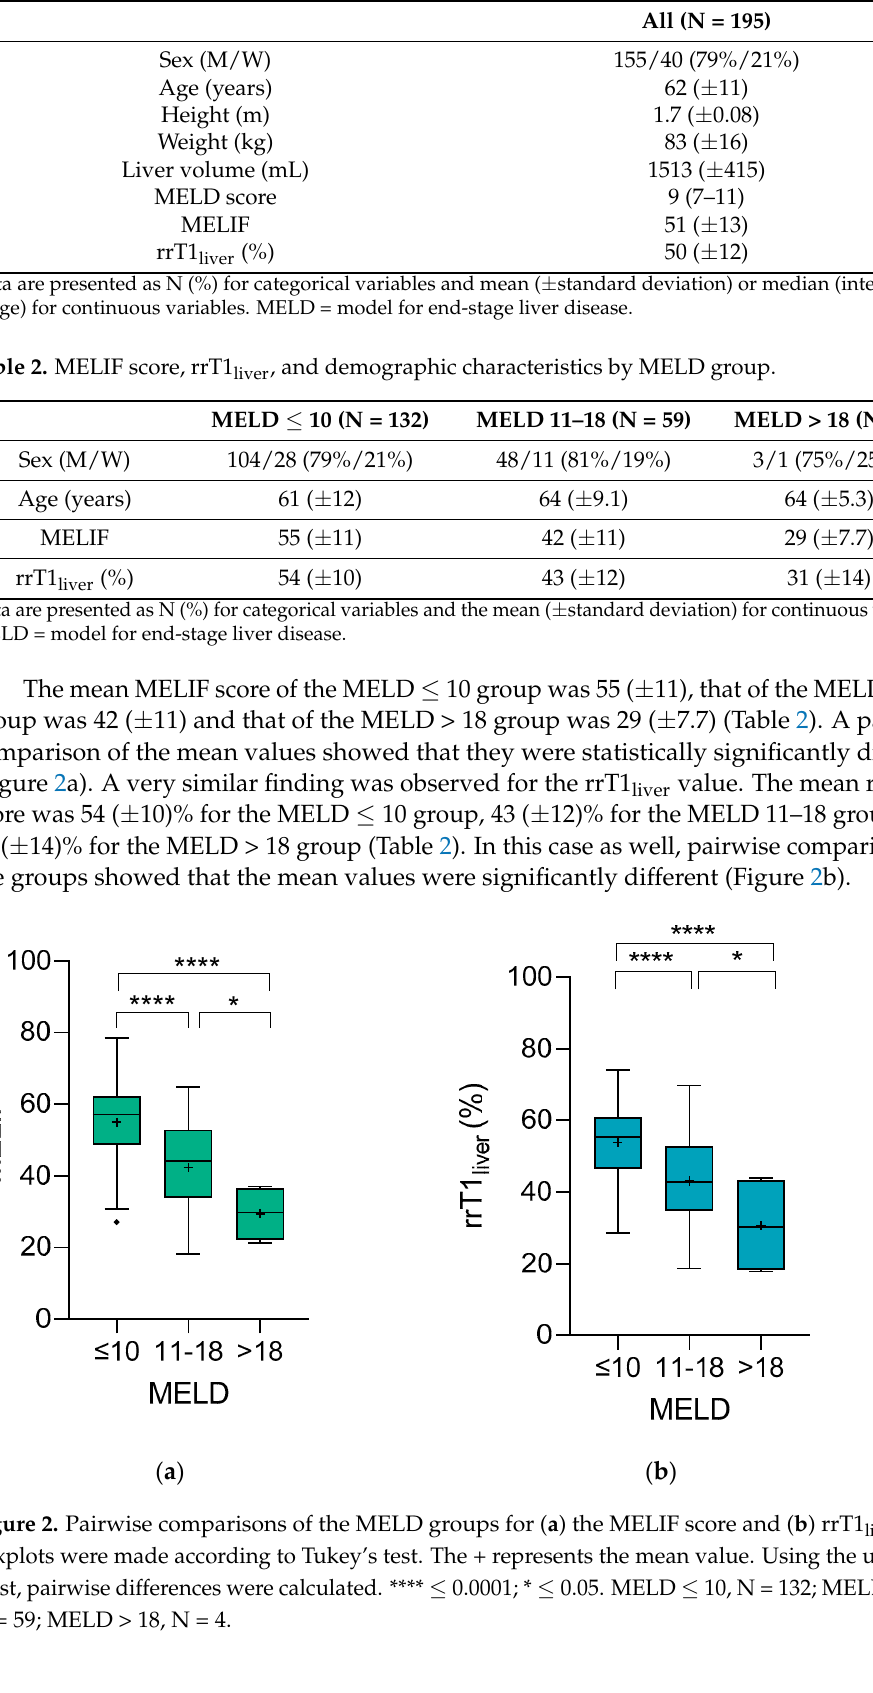
Table 1. Demographic and clinical characteristics of the subjects.